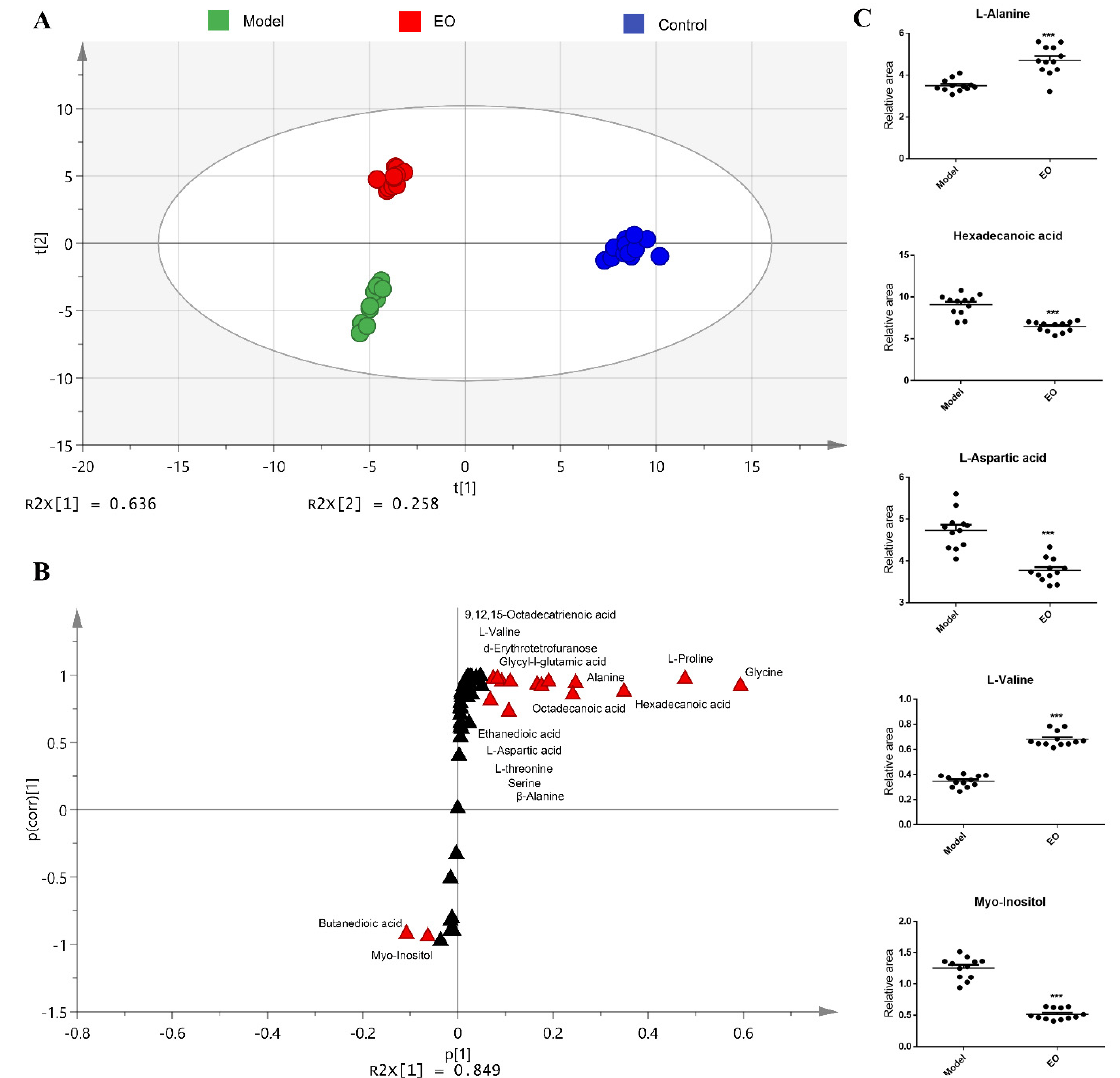
Figure 3. ( A ) Principal Component Analysis (PCA) analysis of three groups. Each dot represents the technological replicate analysis of samples. ( B ) S-plot generated from orthogonal partial least-squares discriminant analysis (OPLS-DA). Dot represents metabolites, which are p [1] < − 0.05 or > 0.05 and p (corr) [1] < − 0.5 or > 0.5 and marked in red dot. ( C ) Scatter diagram of five biomarkers, each dot shows a technical replicate. n = 6. *** p < 0.001 vs. model group.